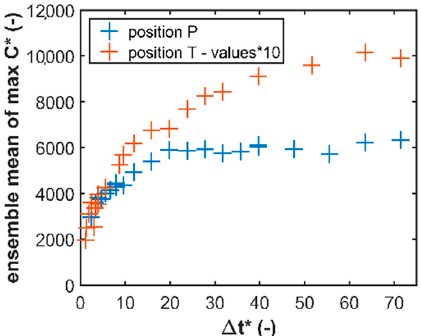
Figure 8. Ensemble mean of maximum concentration (note: the statement values*10 means that the values were multiplied by 10 to be able to show the results of both positions in one figure).